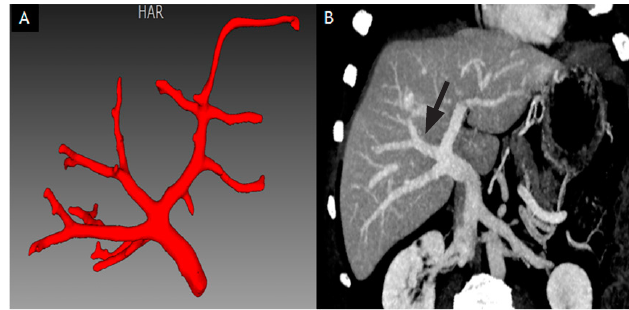
Fig 4. Coronal-oblique maximum intensity projec- tion image showing corresponding right anterior portal vein arising from left portal vein.